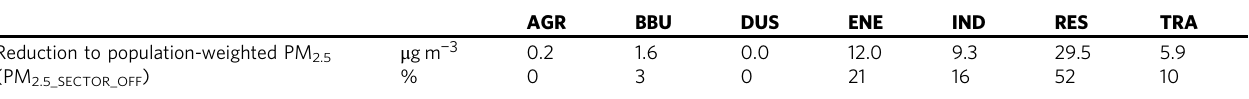
Table 1 Reduction in population-weighted annual mean PM 2.5 concentrations in India caused by removing different emission sectors